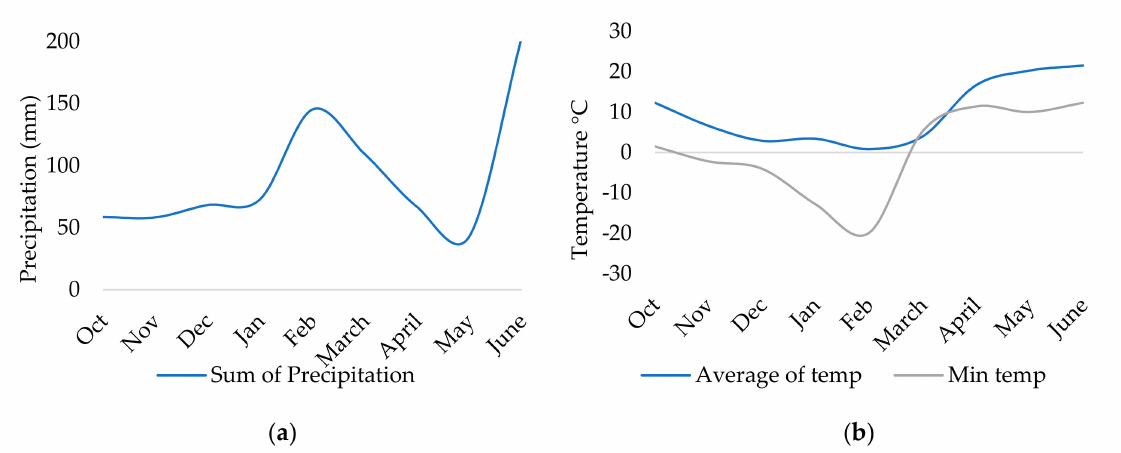
Figure 2. Weather data; precipitation ( a ), average temperature and minimal temperatures ( b ) in Bajmok, during 2018 growing season (site-year